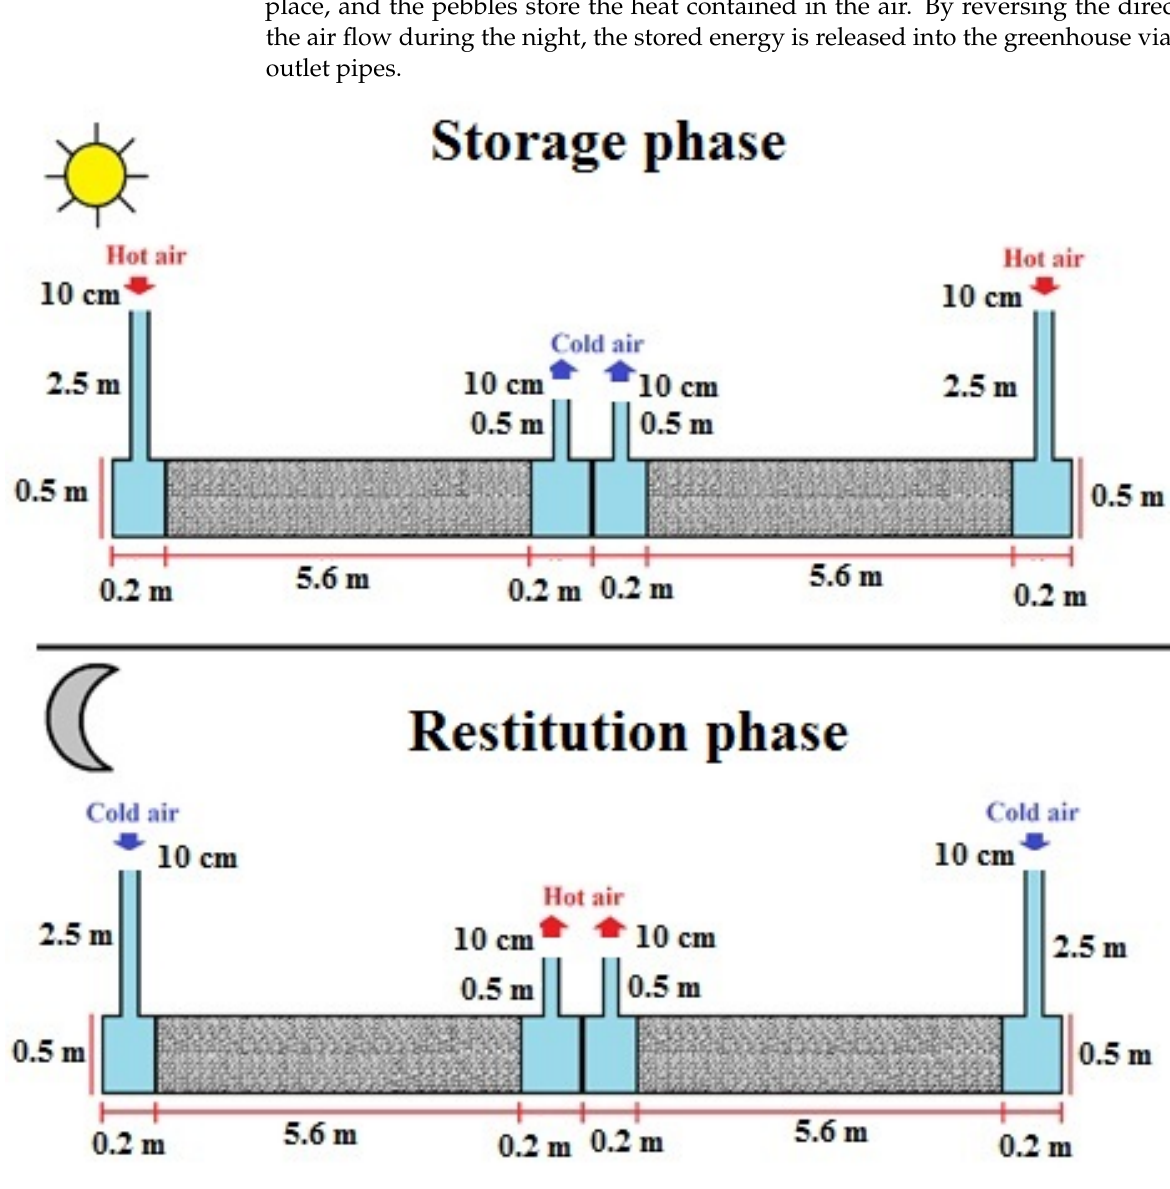
Figure 2. The operating principle of the rock bed heating system.